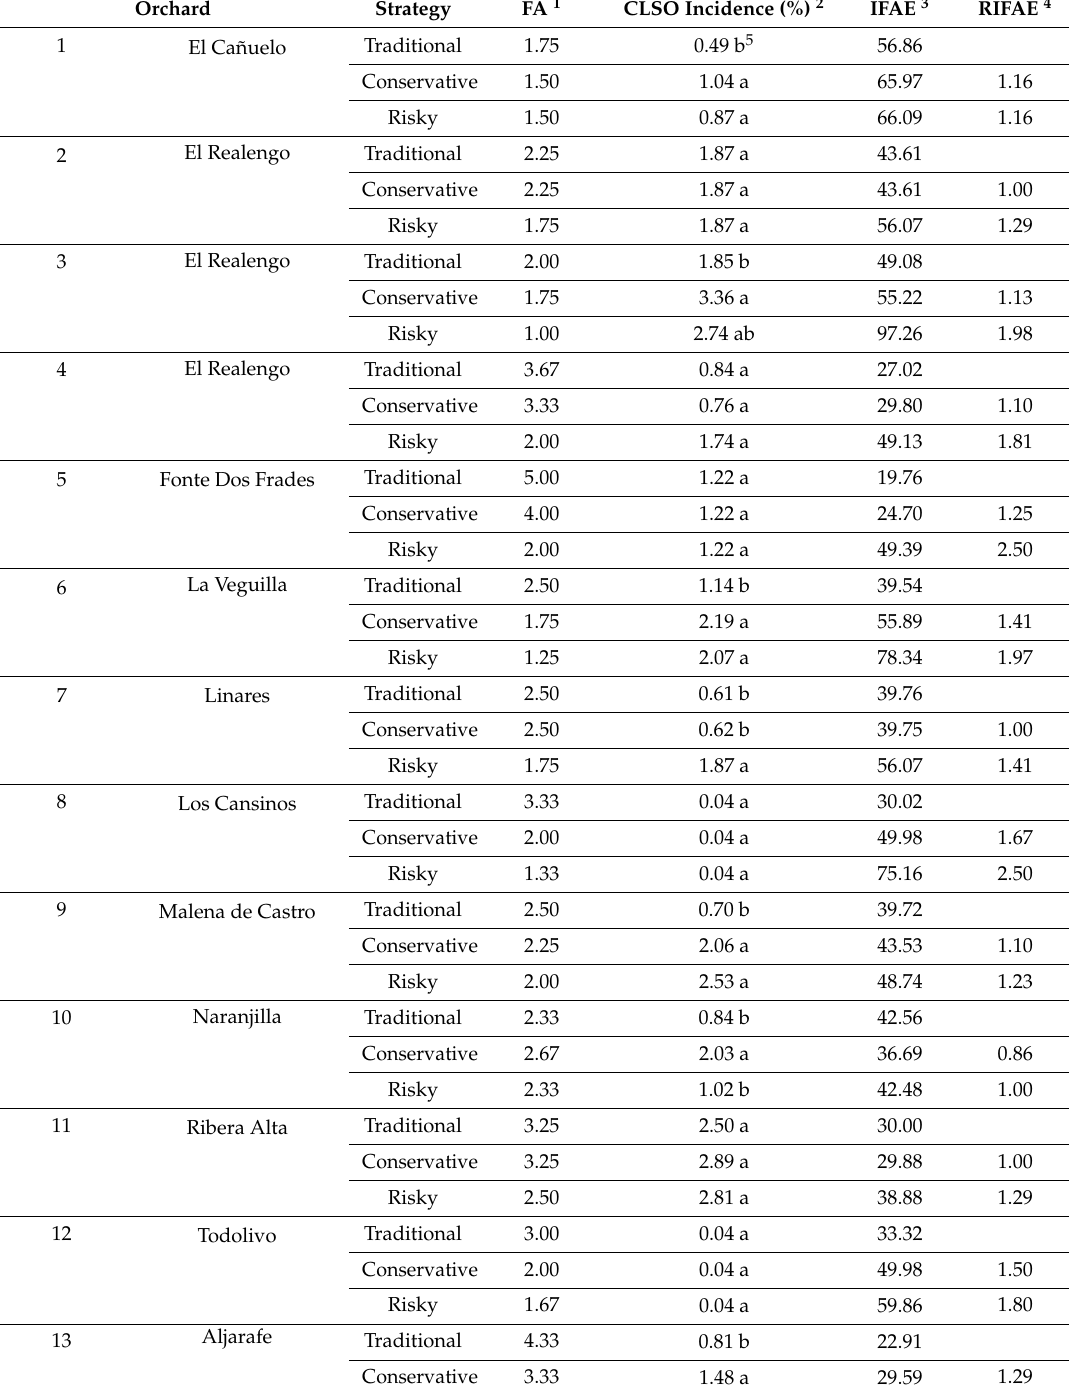
Table 4. Relationship of the average number of fungicide applications (FA), incidence of cercospora leaf spot of olive (CLSO incidence) and Index of Fungicide Application E ffi cacy (IFAE) per each orchard and management